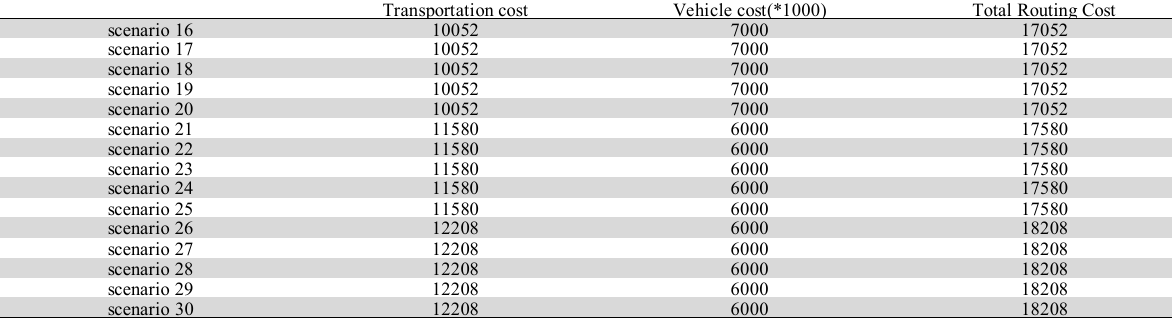
Total Transportation Cost for each Scenario (second 15)